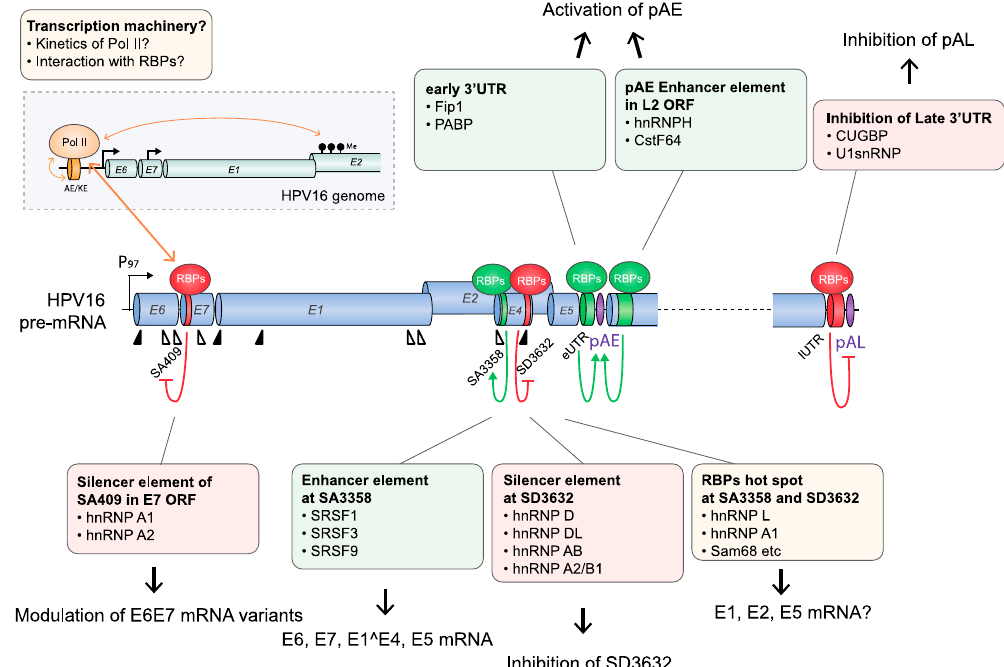
Figure 4. Regulation of HPV16 pre-mRNA splicing and polyadenylation during the HPV16 early life cycle. HPV16 early pre-mRNA splicing and polyadenylation is regulated in a multi-stepwise fashion. Although not yet shown for HPV16, RNA polymerase II (Pol II) kinetics may affect HPV16 splice site selection. Pol II kinetics can be regulated by epigenetic modifications on DNA and/or PTMs of the Pol II C-terminal domain (CTD). In addition, Pol II interacts with various RBPs that may influence RNA splicing. There are multiple cis-acting regulatory RNA elements on HPV16 early mRNAs, indicated here as green cylinders (splicing enhancers) and red cylinders (splicing silencers), that interact with RNA-binding proteins (RBPs) that either activate (green spheres) or suppress (red spheres) splicing or polyadenylation. Proteins that control HPV16 splice sites SA409, SA3358, SD3632 or the HPV16 early and late polyadenylation signals pAE and pAL, respectively, have been identified. Proteins controlling pAE and pAL bind to the early or late untranslated regions, eUTR and lUTR, respectively. Red arrows indicate suppression, and green arrows indicate activation. Proteins that have been identified and shown to control HPV16 splice sites or polyadenylation signals are listed in boxes. See text for more details.